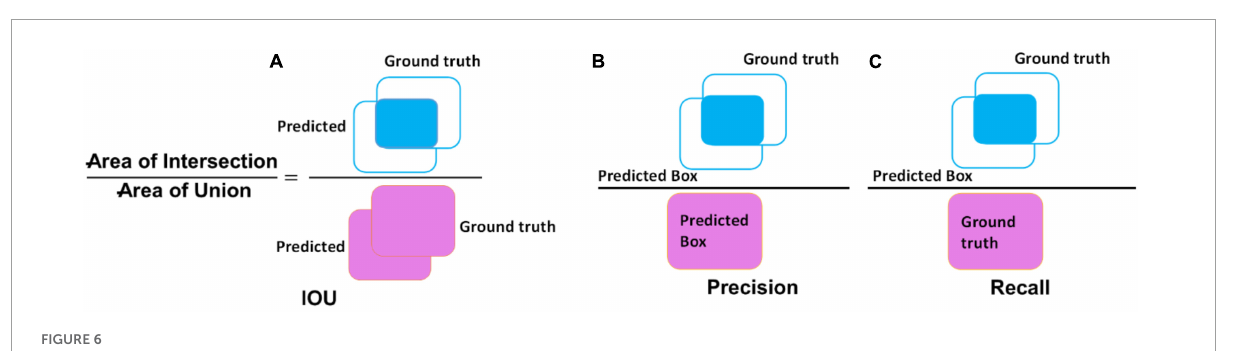
FIGURE6 Visual demonstration of (A) IOU, (B) precision, and (C) recall.